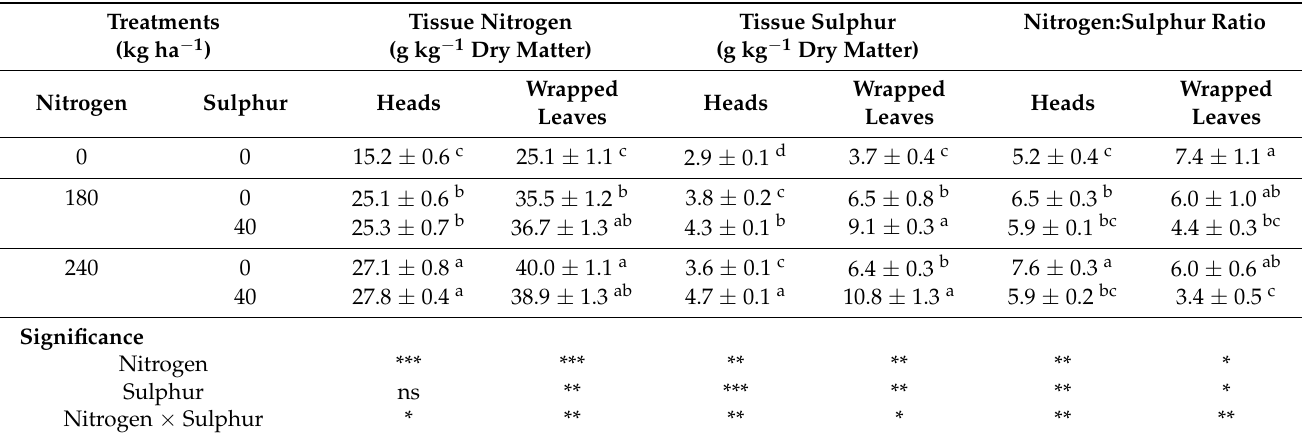
Data are the means ± standard error ( n = 4). Different superscript letters indicate significant differences between fertilisation treatments ( p < 0.01; Duncan’s test). * p < 0.05; ** p < 0.01; *** p < 0.001; ns, not significant (ANOVA), for interactions with and between nitrogen and sulphur fertilisation.